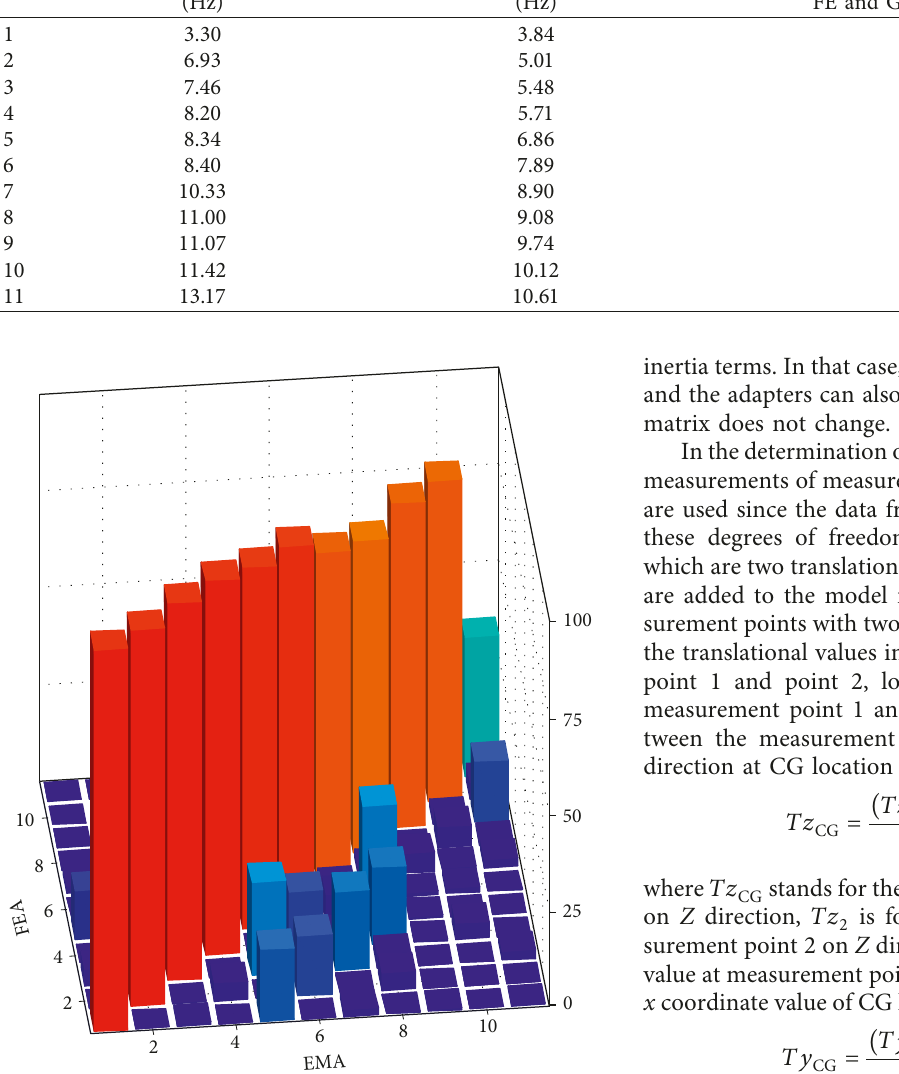
Figure 8: MAC matrix after